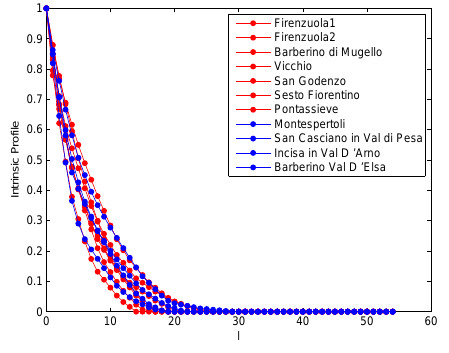
for sites belonging to cluster 1 (in red) and cluster 2 (in Figure 7 – T l